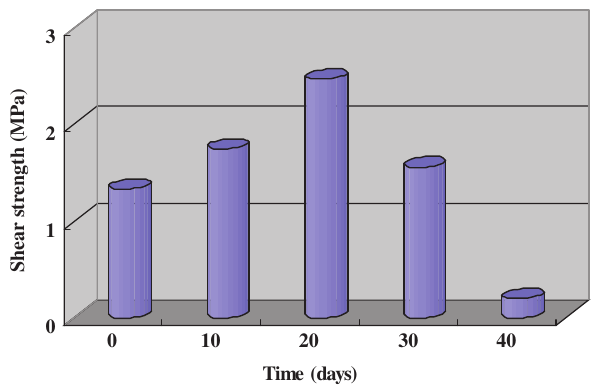
Figure 2: Interfacial bonding strength at different exposure